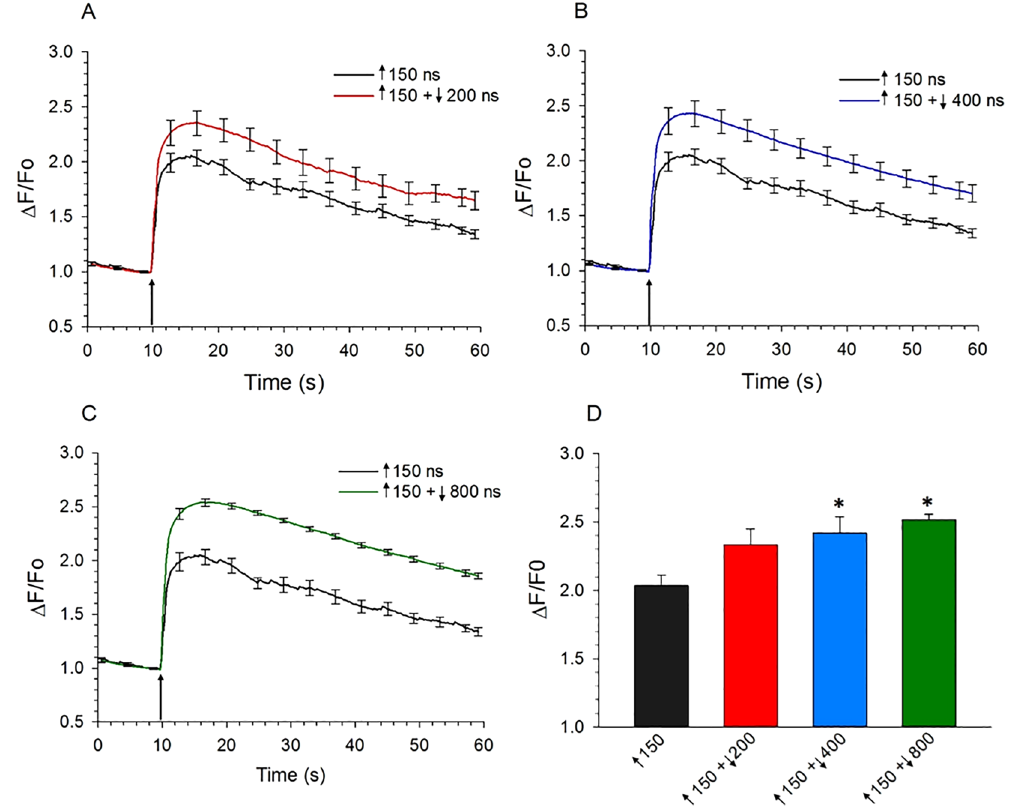
Figure 6. Comparison of the effect of asymmetrical bipolar pulses vs a unipolar pulse on [Ca 2 + ] i when the duration of the negative phase was increased. ( A ) Averaged cell responses ± s.e.m. for the rise in [Ca 2 + ] i in cells exposed to a 150 ns unipolar pulse (n = 8) vs a ↑ 150 + ↓ 200 ns bipolar pulse n = 8). The E-field amplitude for each phase was 3.1 kV/cm and the arrow indicates when the pulse was delivered to the cell. ( B ) Same as in ( A ) except that the bipolar pulse was ↑ 150 + ↓ 400 ns (n = 10), and in ( C ) 150 + ↓ 800 ns (n = 10). ( D ) Bar graph showing the mean ± s.e.m. for the maximal increase in [Ca 2 + ] i for the responses shown in ( A – C ). * p < 0.05, significantly different from the 150 ns unipolar